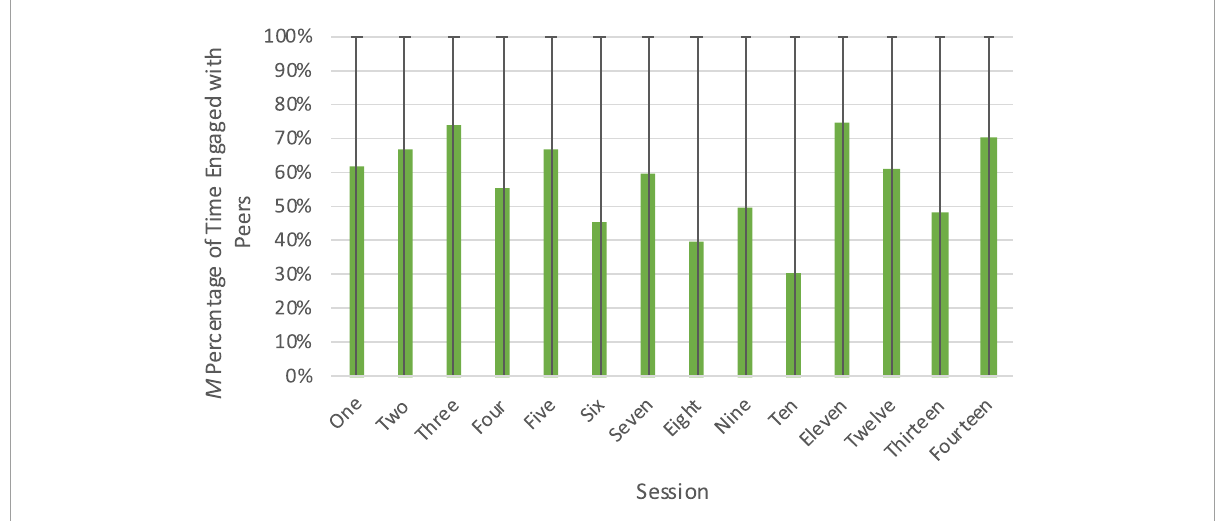
FIGURE4 Engagement with peers across sessions of the Block Play Intervention. Figure shows percentage of engagement out of total coded time (three time intervals) with peers at each session. The range from minimum to maximum engagement is represented by error bars.